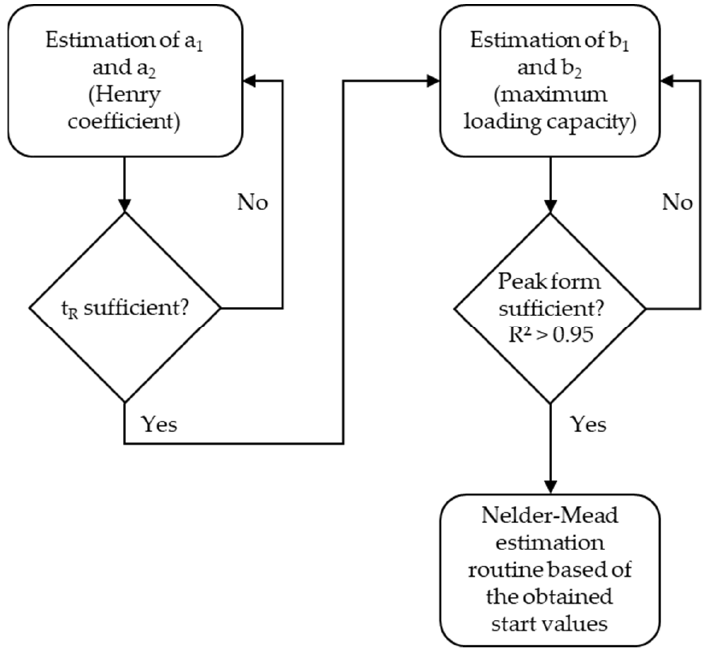
Figure 2. Determination concept of isotherm parameters.